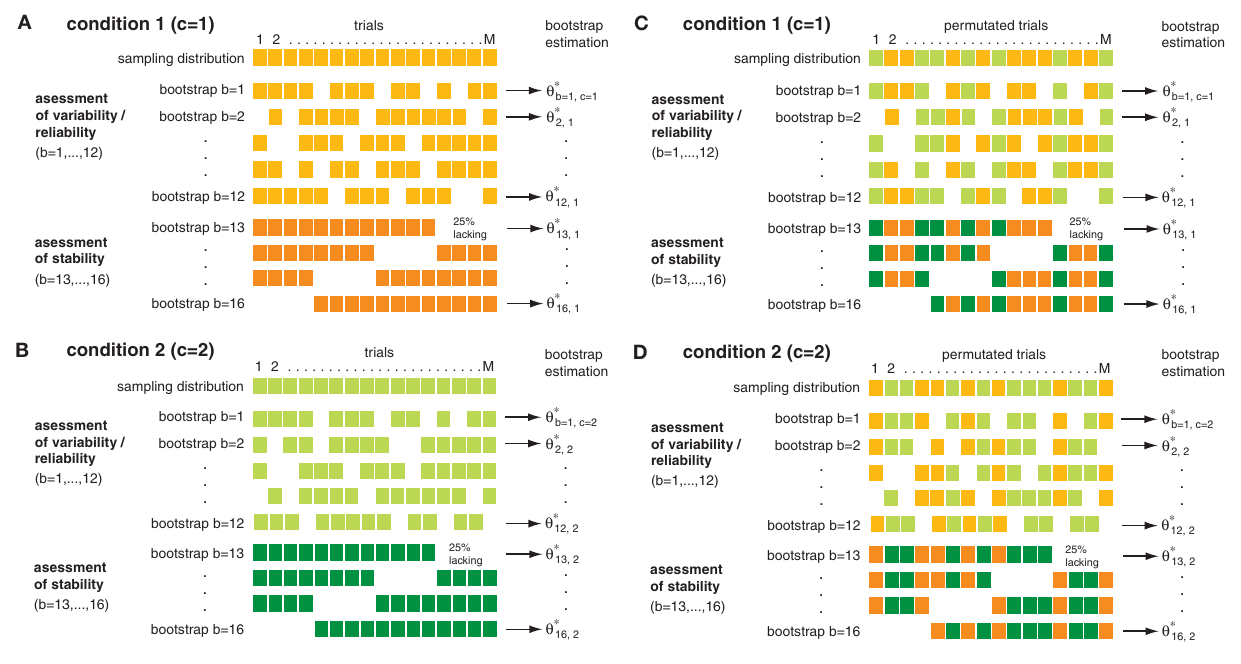
(upper plots). In addition an n-jackknife resampling was used to partition the data into four quarters in order to check for stability during the experiment (lower plots). In total, the bootstrap data comprise 16 sub samples for each condition. To test whether differences between conditions were signifi cant, a second permuted dataset was used. To this end, trials were permuted across conditions. After trial permutation, the same n-jackknife bootstrap procedure was employed on the permuted